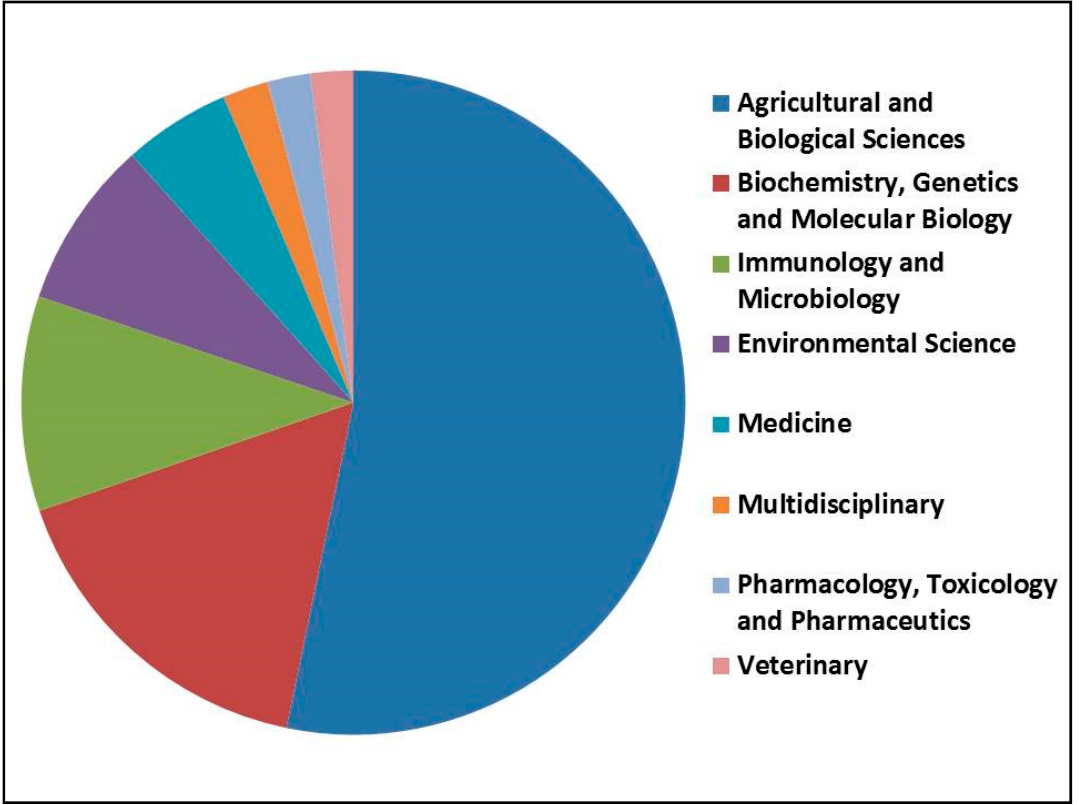
Figure 4. Subject area in which articles on nematodes + plants are published.